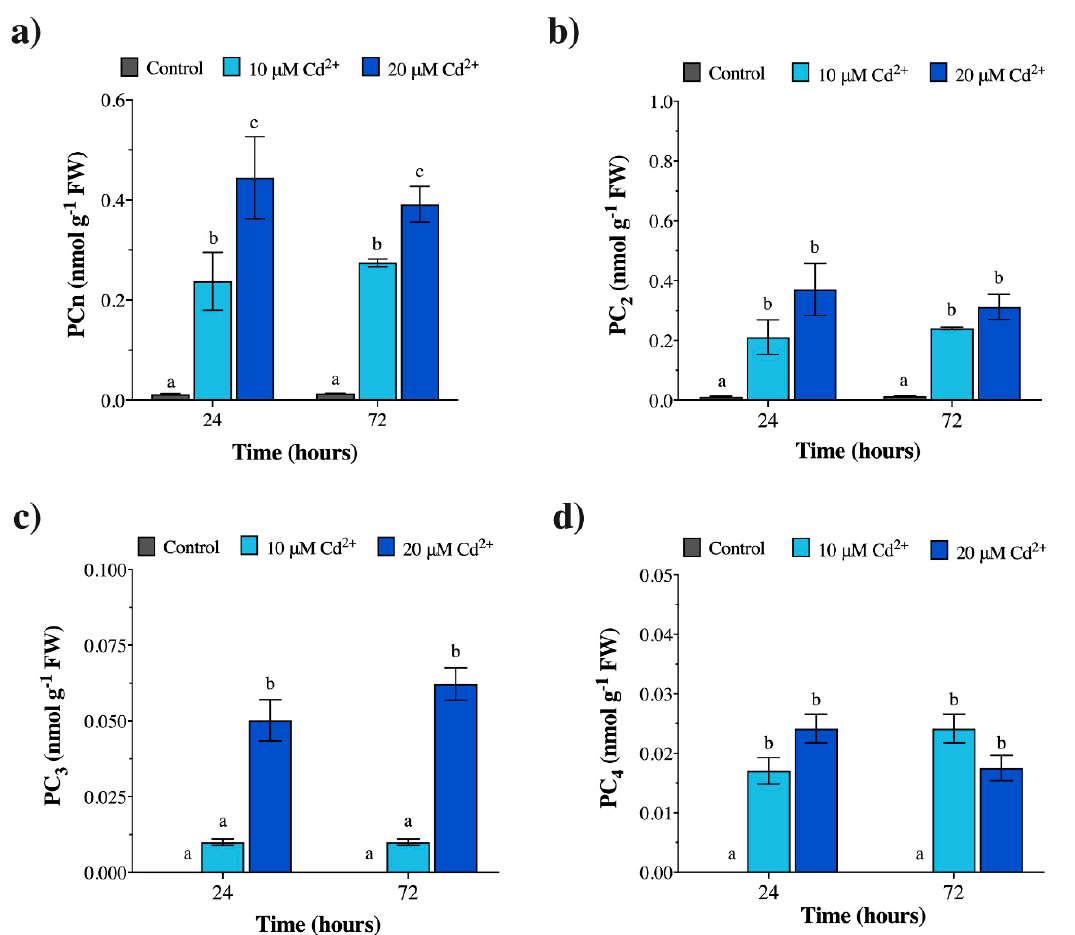
Figure 2. Phytochelatin (PCn) concentrations (nmol g − 1 FW) in Geitlerinema sp. PCC 7407 cultures exposed in vivo to 0 (control), 10, and 20 µM Cd. Sampling times equal to 24 and 72 h of Cd exposure. ( a ) Total PCn; ( b ) PC 2 ; ( c ) PC 3 ; ( d ) PC 4 . Values are the mean ± SE; n = 5. Different letters indicate